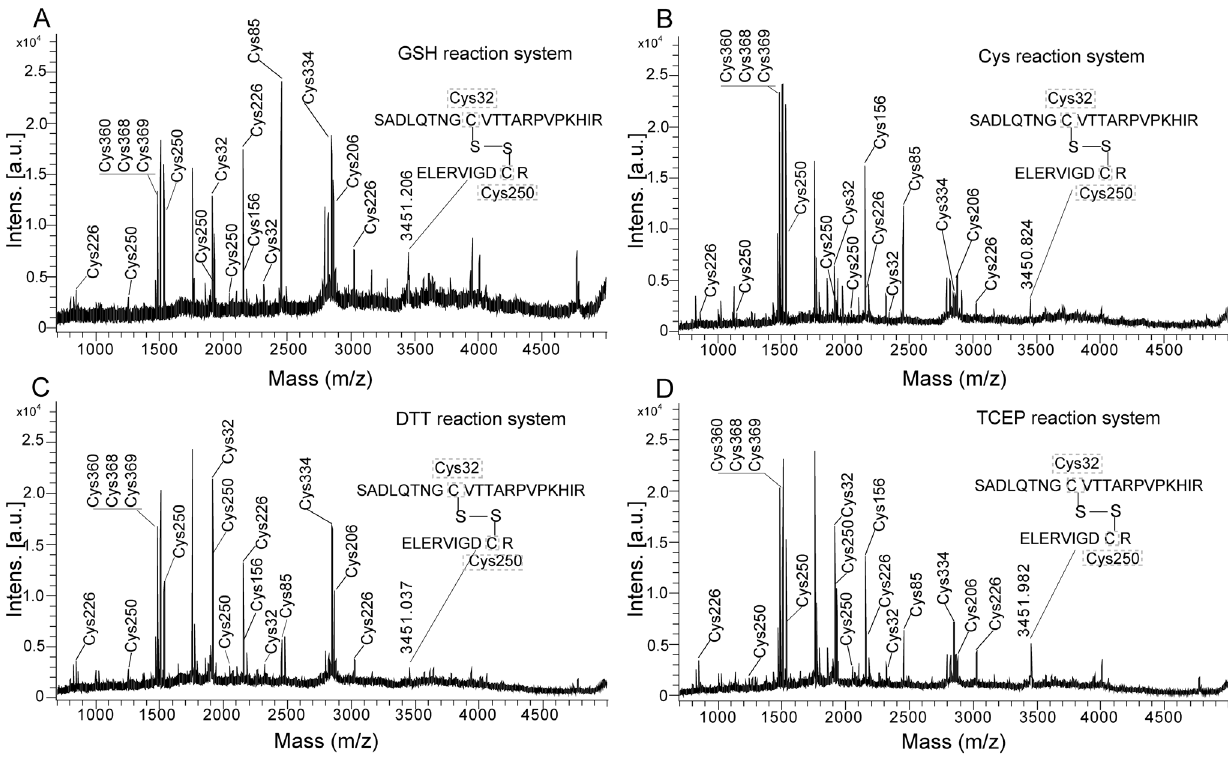
Figure 3. MALDI-TOF-MS spectra for the digested hAS3MT after it catalyzed the iAs 3 + methylation in GSH (A), Cys (B), DTT (C), or TCEP (D) reaction system. Before analysis, hAS3MT catalyzed the iAs 3 + methyation in GSH, Cys, DTT, or TCEP reaction system at 37 u C for 60 min.